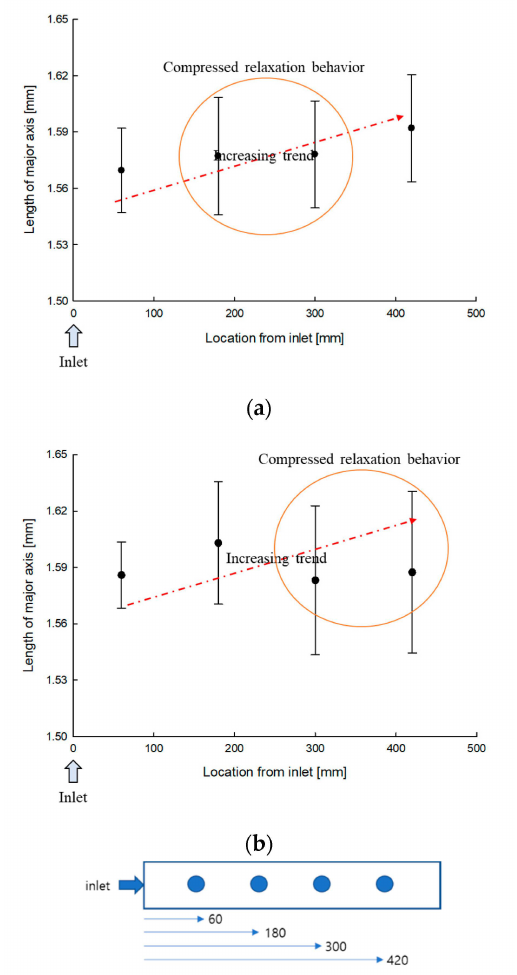
Figure 6. Major axis of the tow for the flow rates of 50 mm 3 /s ( a ) and 200 mm 3 /s ( b ) at the different positions (all dimensions are in